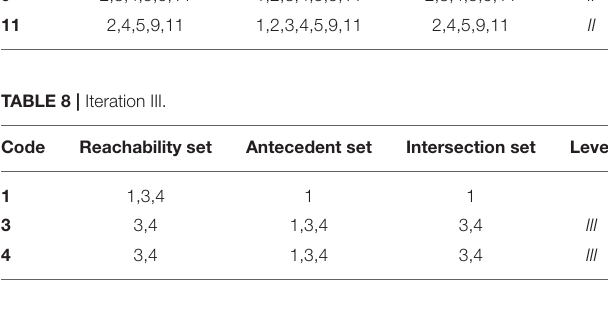
TABLE 9 | Iteration